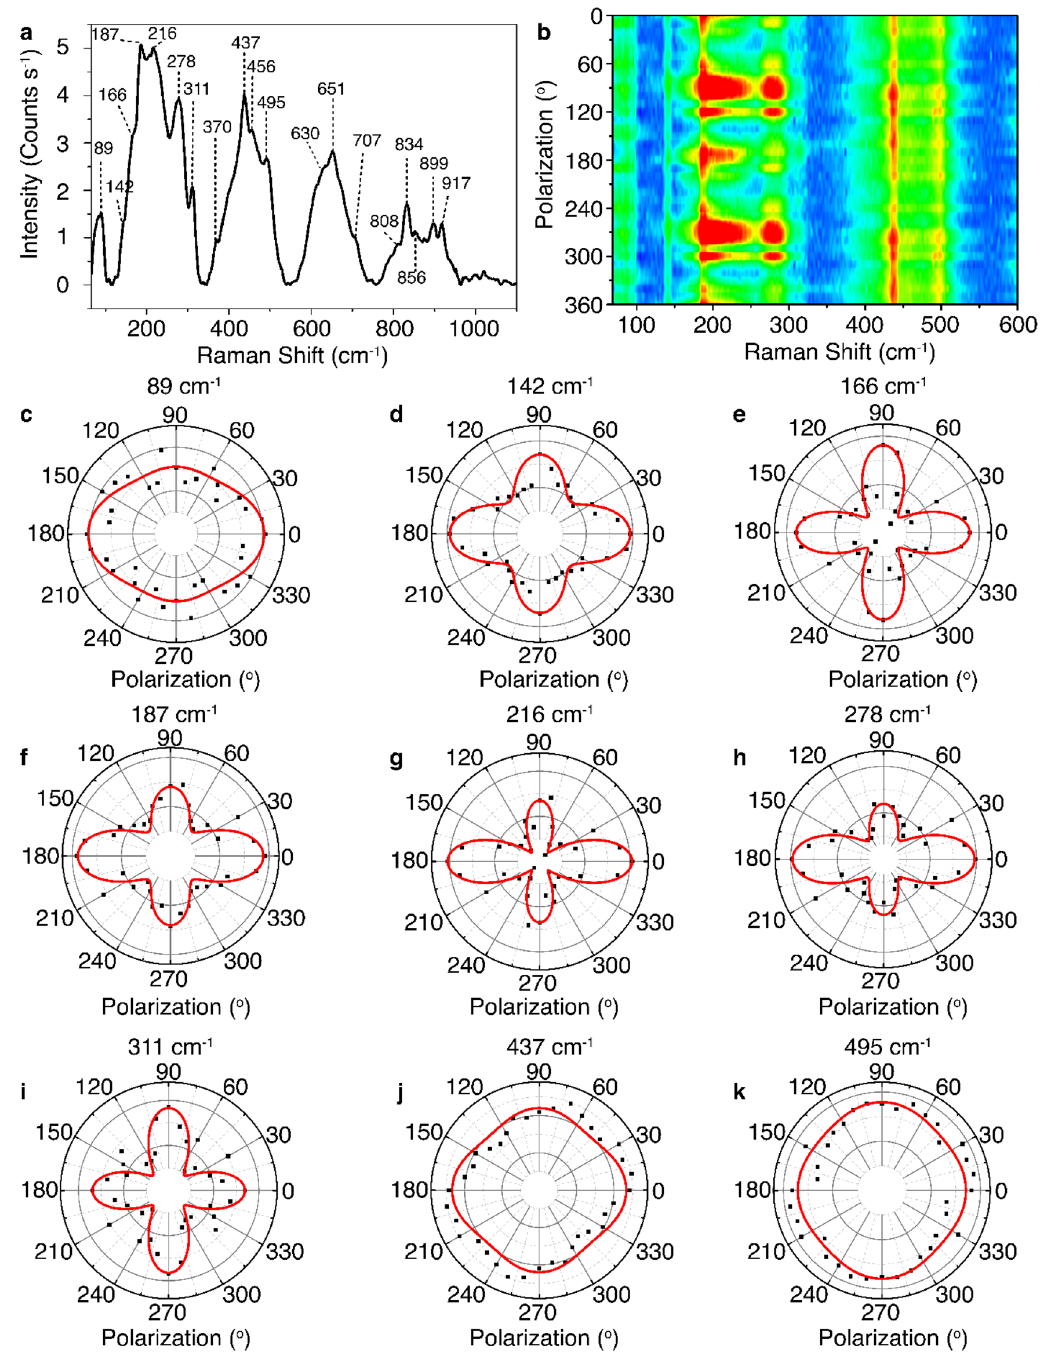
Figure 3. ( a ) Raman spectrum collected from the 26 nm-thick abramovite flake as shown in Fig. 1c. ( b ) Contour color map of the Raman intensity for the parallel polarization components of the Raman modes as a function of the incident linear polarization angle from the same abramovite flake. ( c – k ) Polar plots of the Raman intensity for the parallel polarization components of the Raman modes at 89, 142, 166, 187, 216, 278, 311, 437, and 495 cm −1 ,